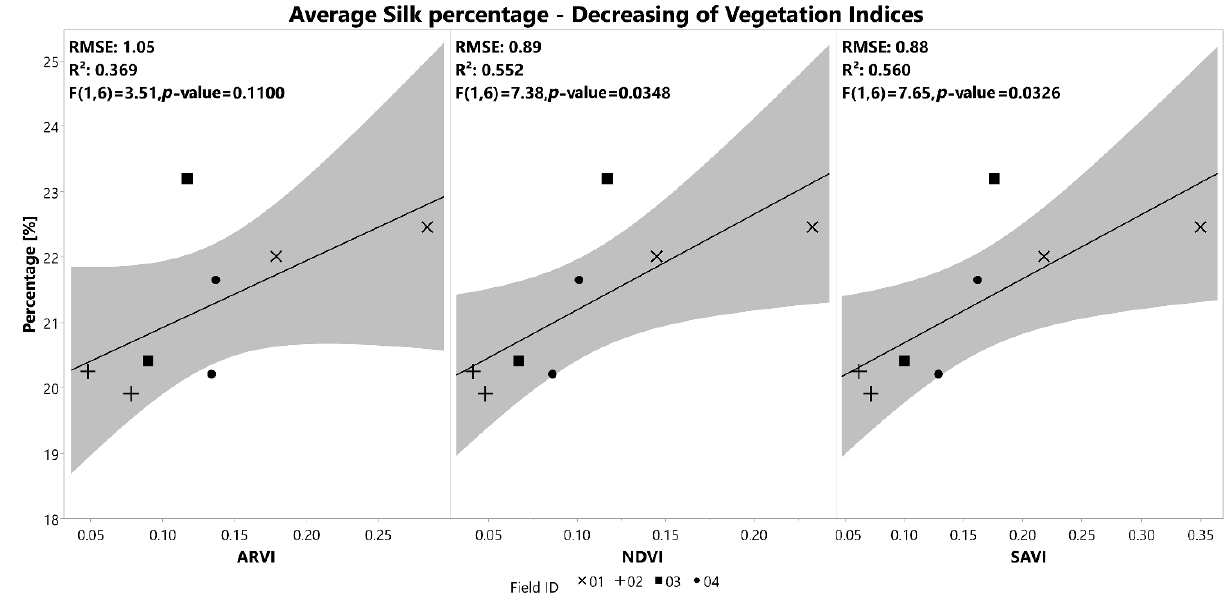
Figure 8. Average silk percentage of cocoons [%] regressions in relation to decreasing vegetation indices during the fifth instar of B. mori . Gray shaded areas represent the confidence interval of regression at 95%.